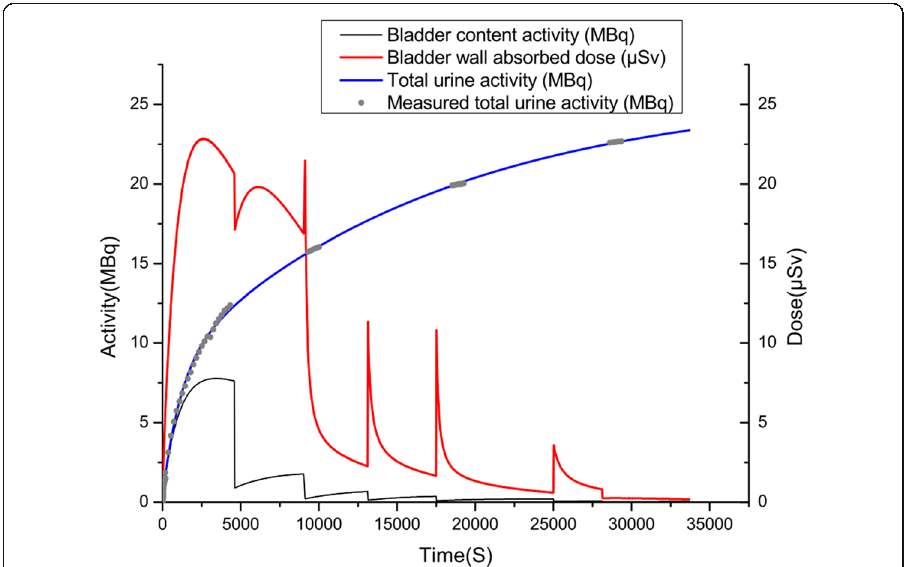
Fig. 3 Representative time activity curve of bladder content (not decay corrected), fitting total urine activity and measured total urine activity (including bladder urine and excreted urine, decay corrected) and absorbed dose to the bladder